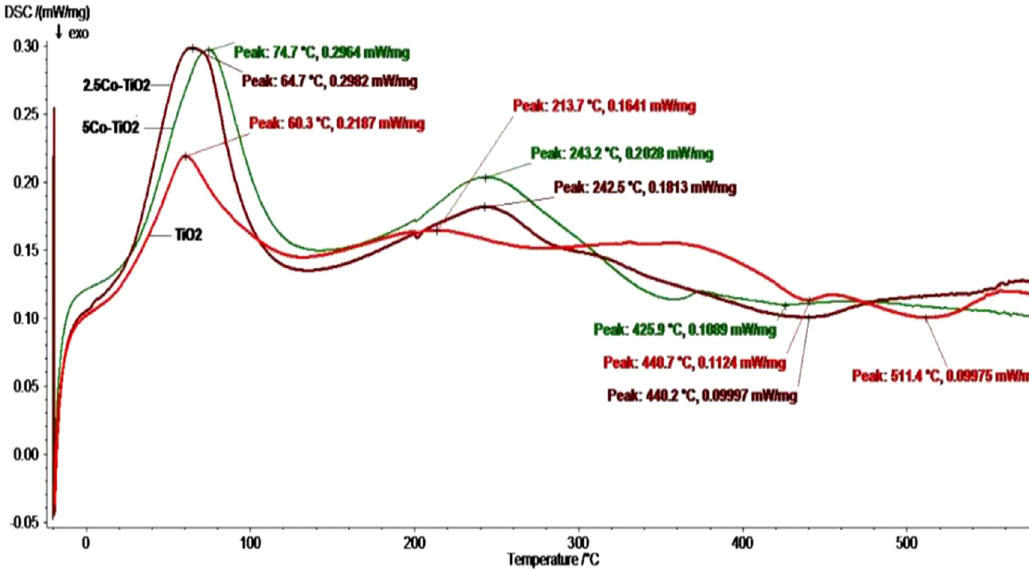
Fig. 7. DSC lines of un-doped and TiO 2 doped with 2.5 and 5% wt.% Co respectively.